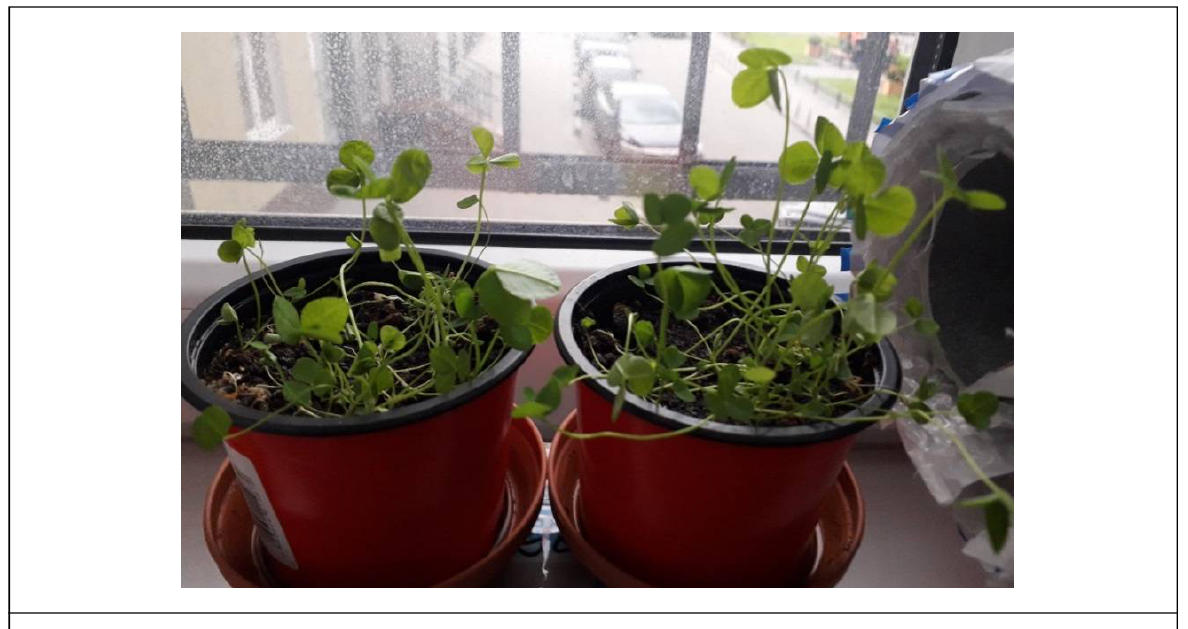
Figure 6: On the left is ordinary water, on the right is magnetized water (May 20, 2019)